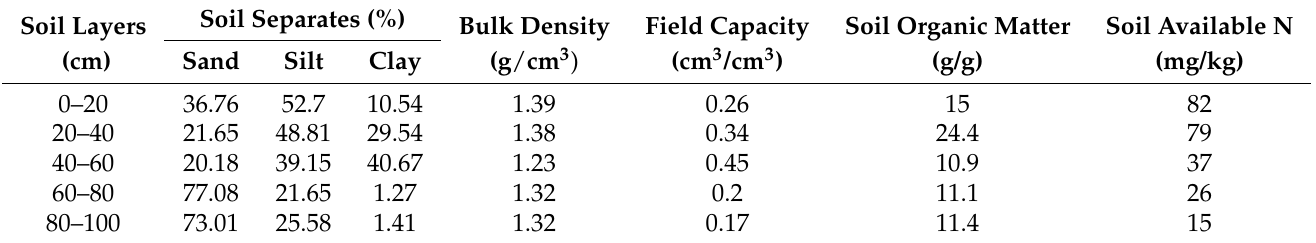
Table 1. Physical and chemical properties and fertility of soil in the experiment field. Soil Layers Soil Separates (%) Bulk Density Field Capacity Soil Available